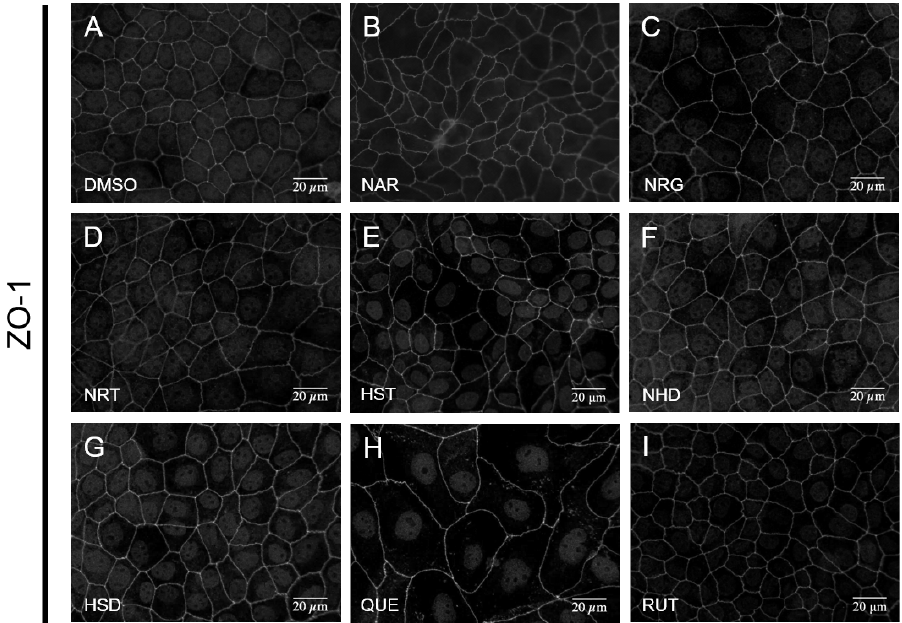
Figure 5. Effects of flavonoids on TJ integrity of MDCK II cells. Immunofluorescence staining of ZO-1 images are arrayed. Cells were treated with flavonoids at a concentration of 100 μM for 48 h. ( A ) control (DMSO), ( B ) NAR, ( C ) NRG, ( D ) NRT, ( E ) HST, ( F ) NHD, ( G ) HSD, ( H ) QUE, and ( I ) RUT. Scale bar = 20 μM. Brightness is modified to 160%. MDCK: Madin–Darby canine kidney, ZO-1: zonula